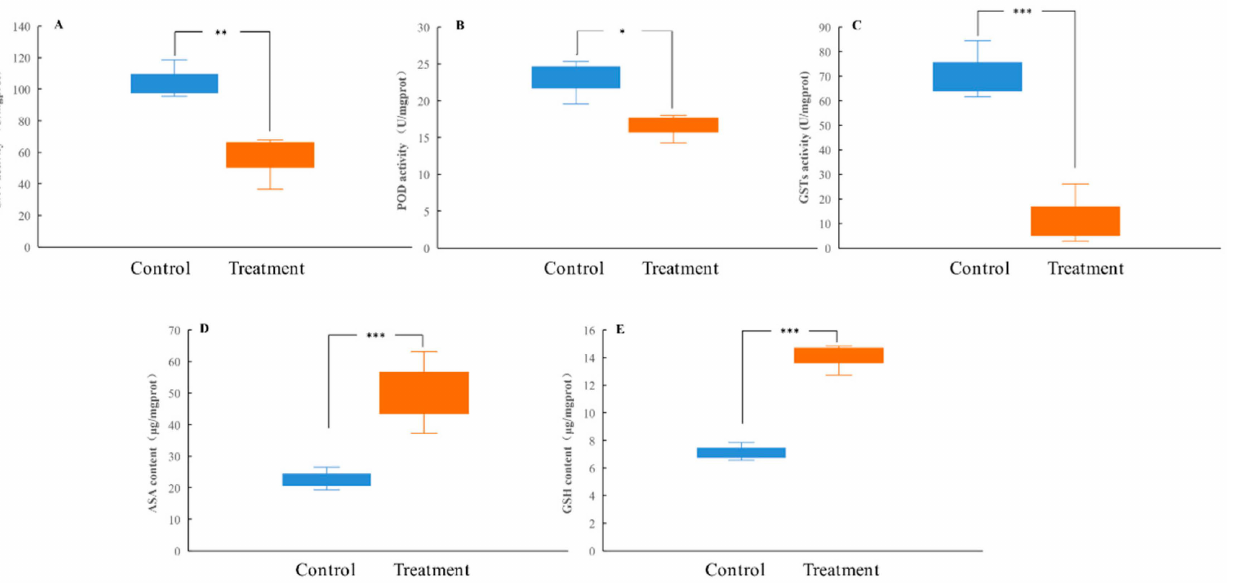
Figure 3. Effect of tannic acid on the activities of CAT ( A ), POD ( B ), and GSTs ( C ) and the content of ASA ( D ) and GSH ( E ) in the H. cunea larvae at the 6th instar. Asterisk indicates significant differences between control/treatment groups ( n = 3; independent samples t -test; *, p < 0.05; **, p < 0.01; ***, p <